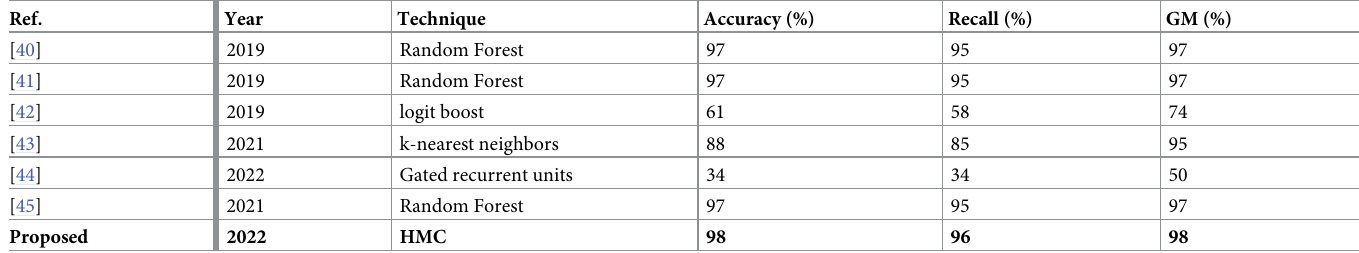
Table 7. Performance analysis of the proposed approach with state-of-the-art studies.